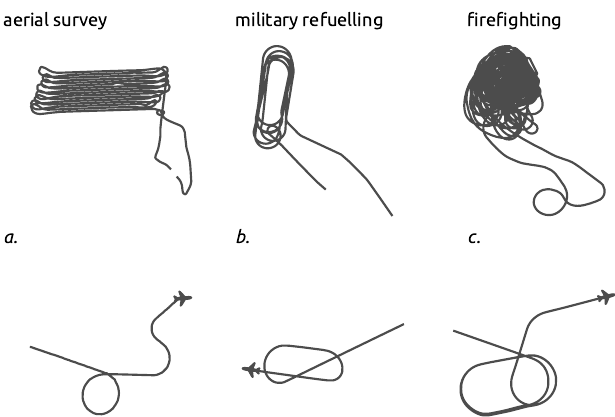
Figure 8. Holding patterns: A set of rules based on sets of parallel lines or self-intersecting segments may mistakenly select different patterns like those displayed on the first line. On the other hand, the line between a holding pattern and other sequencing procedures is thin: the trajectory in a. has been subject to sequencing actions by the ATC because of heavy traffic, but the oval shape is not visible; the trajectory in b. looks like a holding pattern was initiated, but the full shape is not visible. The trajectory in c. stacks two holding patterns, but the way out of the pattern should probably be labelled as